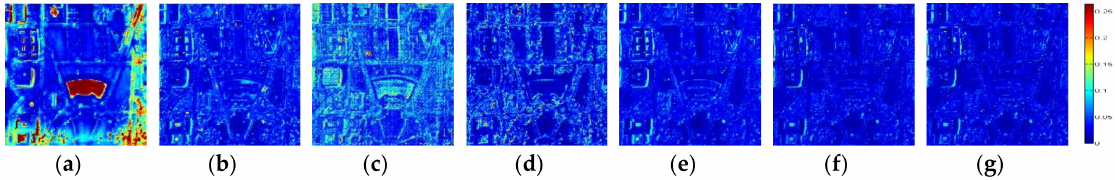
Figure 14. SAM maps of the enhanced images for Washington D.C. dataset. (1/2 subpixel shift): ( a ) MAP; ( b ) CNMF; ( c ) Bayesian; ( d ) NSSR; ( e ) LASUF; ( f ) LASUF-OM, k = 3; ( g ) LASUF-OM, k = 6.